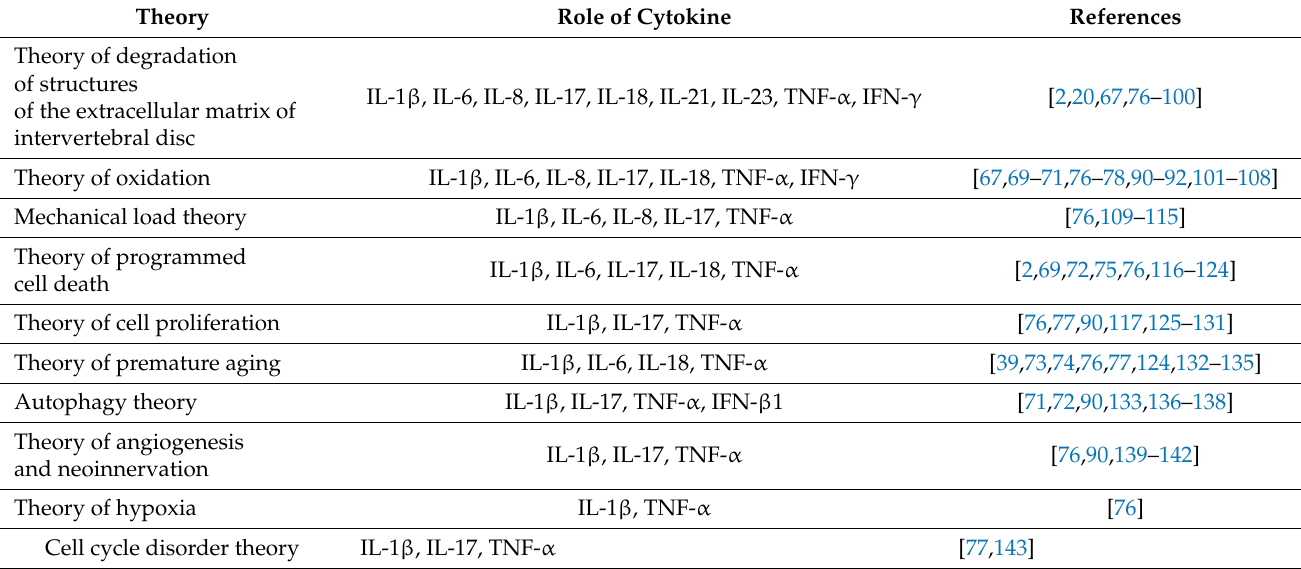
Table 2. Theories of cytokine role in intervertebral disc degeneration